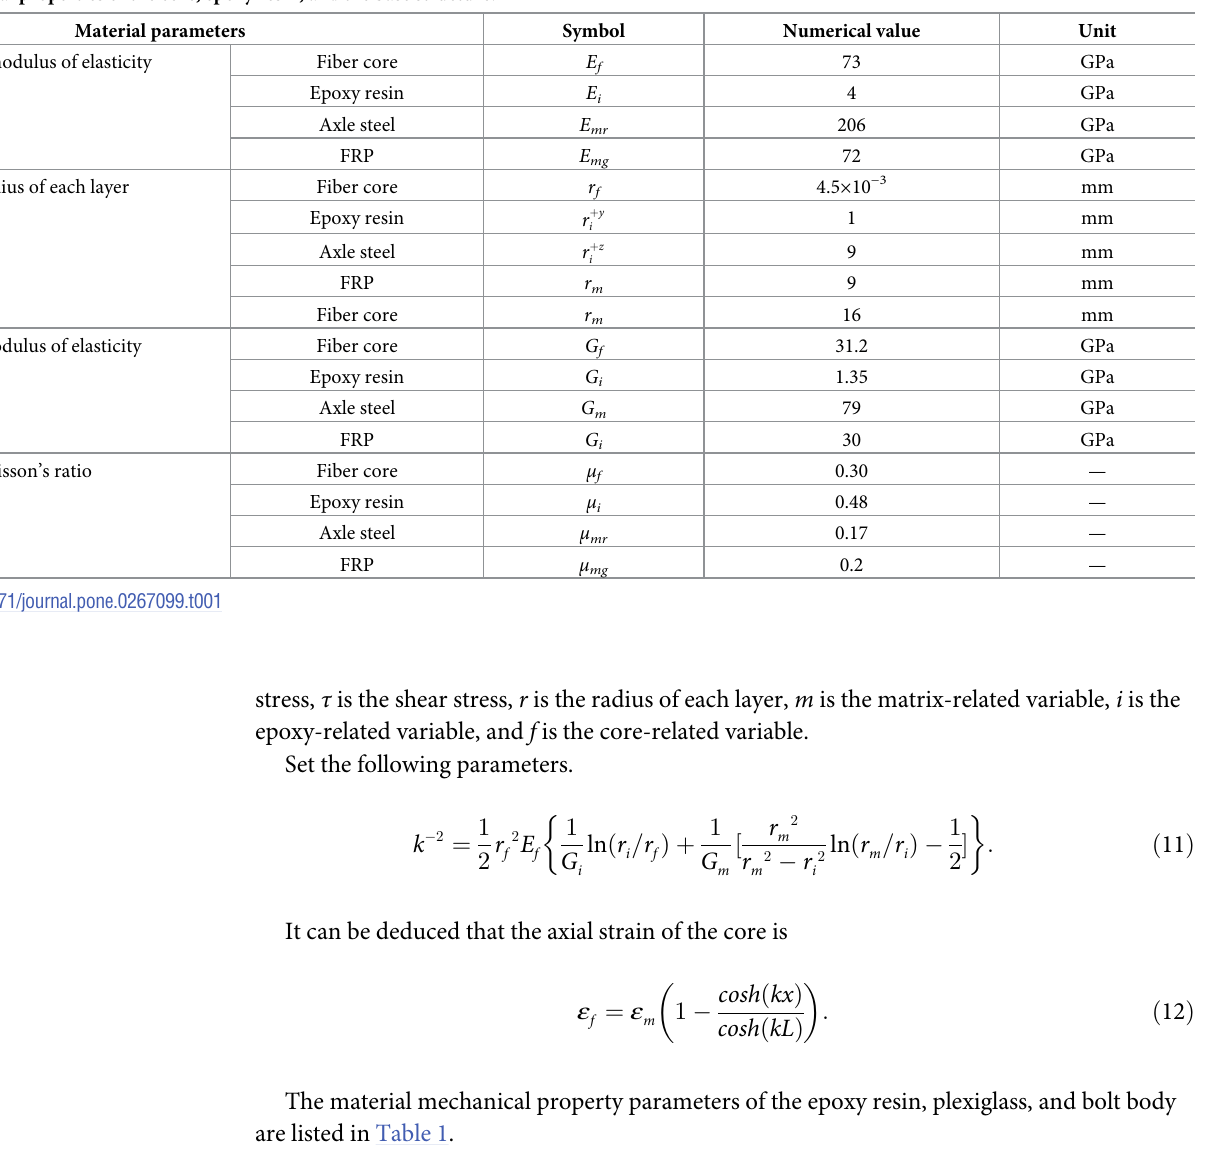
The material mechanical property parameters of the epoxy resin, plexiglass, and bolt body are listed in Table 1. The different shear elastic moduli of the two matrix structures are the same in all directions, and the strain transfer rate at each point of the FBG sensor within the gauge length is shown in Figs 4 and 5. As shown in Figs 4 and 5, the abscissa is the distance from the center of the FBG sensor, and the ordinate is the strain transfer rate of different materials in different directions. From the analysis of the strain transfer rate of the two different materials, it can be observed that the farther the FBG sensor, the smaller the strain transfer rate; the closer to the FBG sensor, the greater the strain transfer rate, and the two ends are zero. The largest strain transfer rate occurred at the center point. The changing trend close to the center point is slower than that at the farther position of the sensor center point. It shows that within the distance of the gate area (the length of the gate area is 10 mm, i.e., the abscissa of the figure is -5–5 mm), the strain transmission loss between each material is minimal. The stress acting on the bolt can be accu- rately reflected by the wavelength change of the FBG sensor.